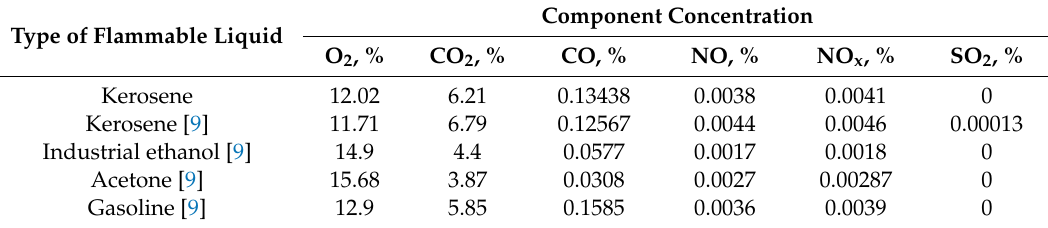
Table 1. Average concentrations of CO 2 , CO, NO x , NO, SO 2 , and O 2 in kerosene combustion products, as well as data from the work in